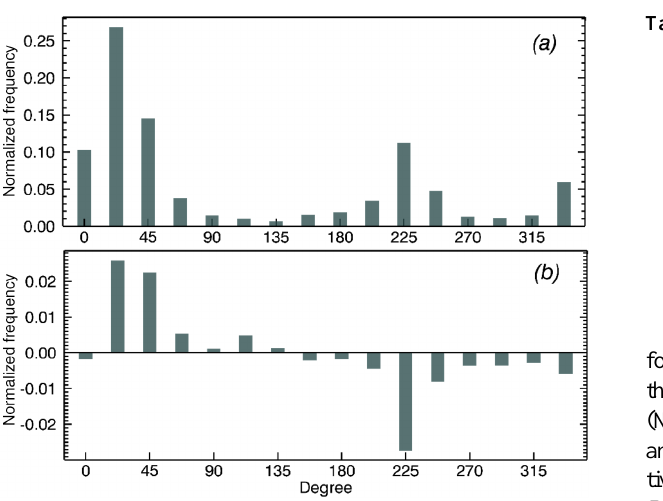
Figure 7. (a) Histogram of normalized frequency of 16 wind di- rections for the entire study period. (b) Difference values of wind direction frequencies between DT and NT (DT–NT).